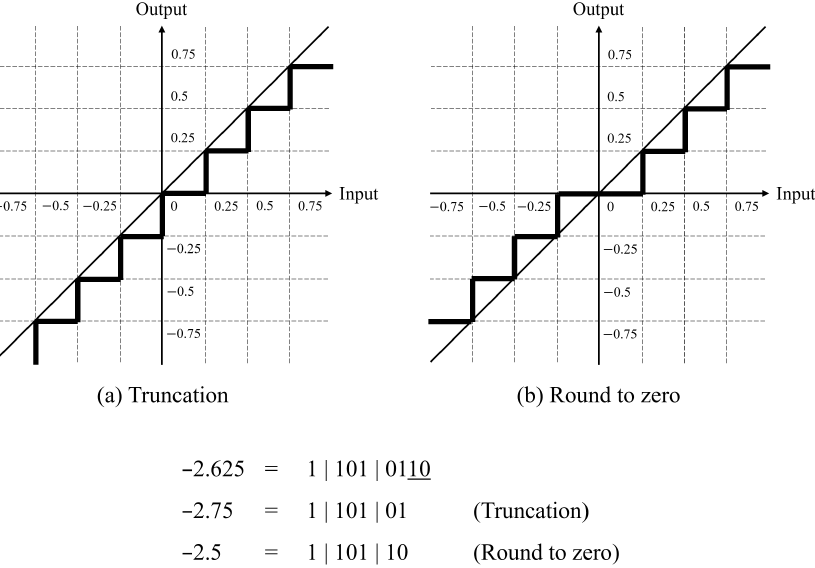
Figure 14. Comparison of truncation and round-to-zero operations for fixed-point data. The carry MAC module passes an extra carry bit to the adder instead of performing the rounding function. The lower six bits are completely truncated. The carry bit is the sign bit of the resulting signed fixed-point data. Because negative values are represented as two’s complement, truncating the lower bits rounds the value to minus infinity, in contrast to positive values, which are rounded to zero. The added carry bit pulls a negative value toward positive